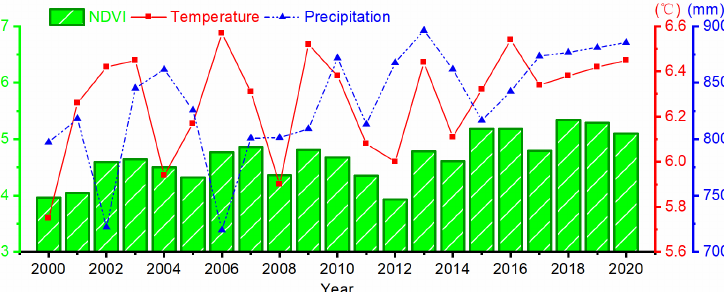
Figure 7. Statistical chart of NDVI, temperature and precipitation from 2000 to 2020.